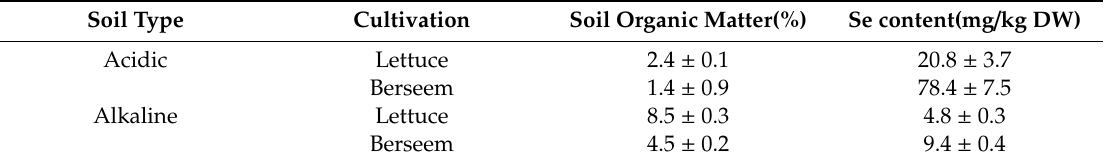
Table 5. Soil organic matter and Se content (mg / kg dry weight) of lettuce and berseem crops grown in soils with a pH range of 6.5 to 8.1 at the end of the experiment. The mean ± SE of five replicates is given.